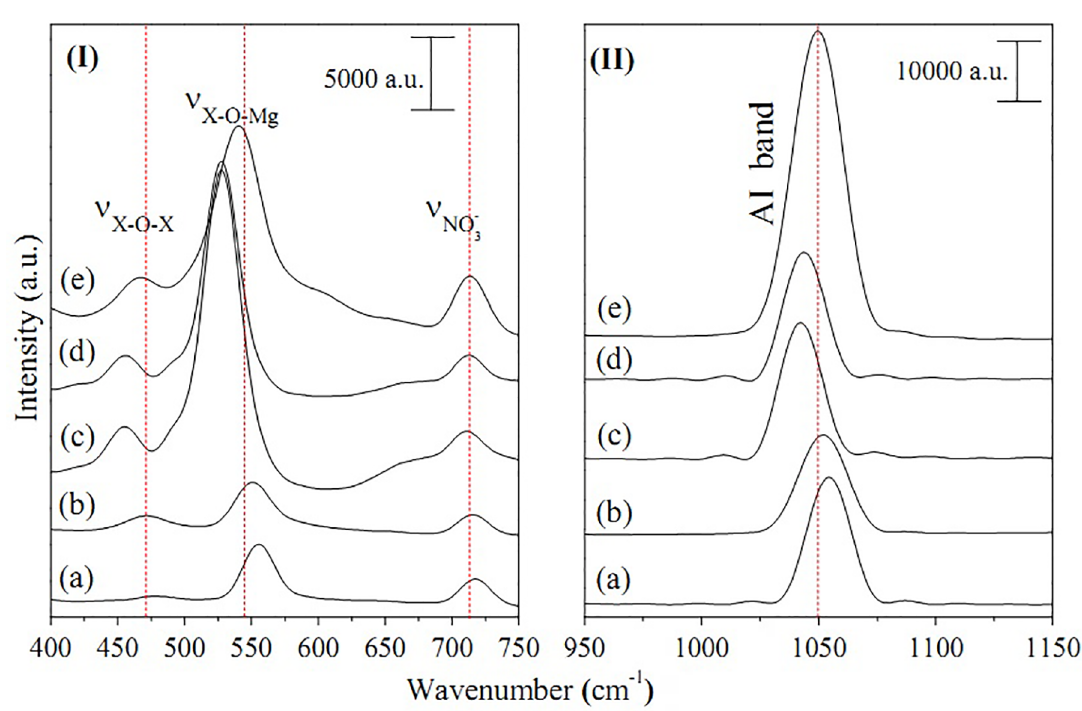
Al-LDH, (b) Mg Al- 2 3